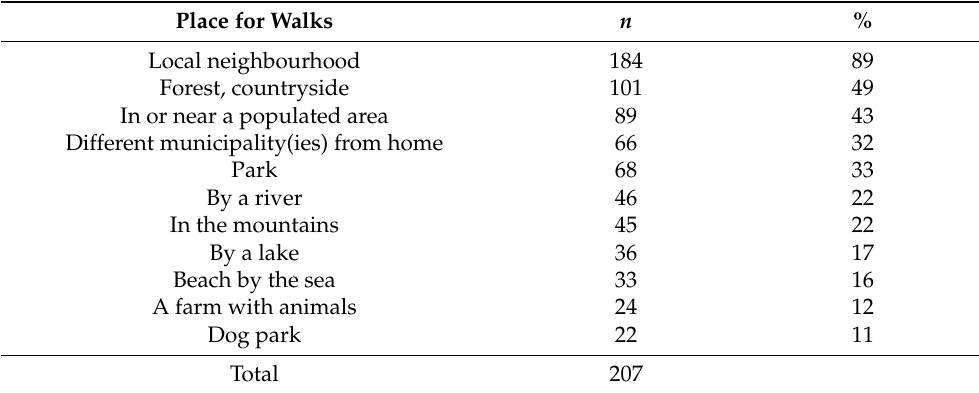
Table 3. Description of where case dogs were walked the 14 days before illness onset. Online survey to veterinarians with dog patients with acute haemorrhagic diarrhoea in dogs, Norway,